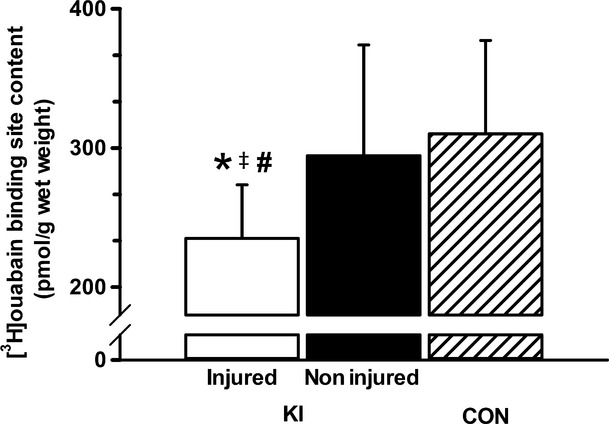
Vastus lateralis muscle [3H]ouabain binding site content in the injured and noninjured leg of KI and in CON. *Less than the noninjured leg (P < 0.05), #Less than CON (P < 0.05), &ddagger;Moderate effect size compared to noninjured leg. Values are Mean ± SD, KI, n = 6 for each leg; CON, n = 7.